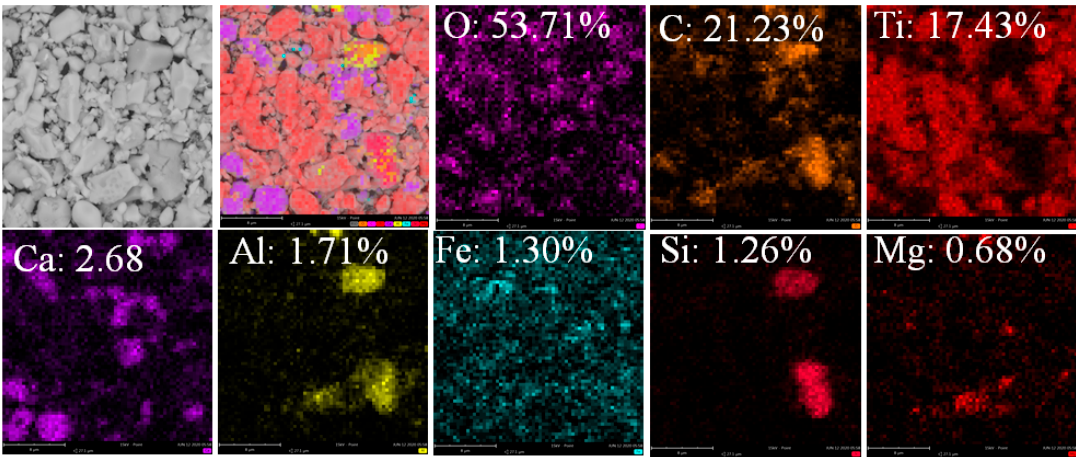
Figure 11. SEM-EDS of nonmagnetic part (EDS: atomic concentration). Scale bar: 8 µ m.